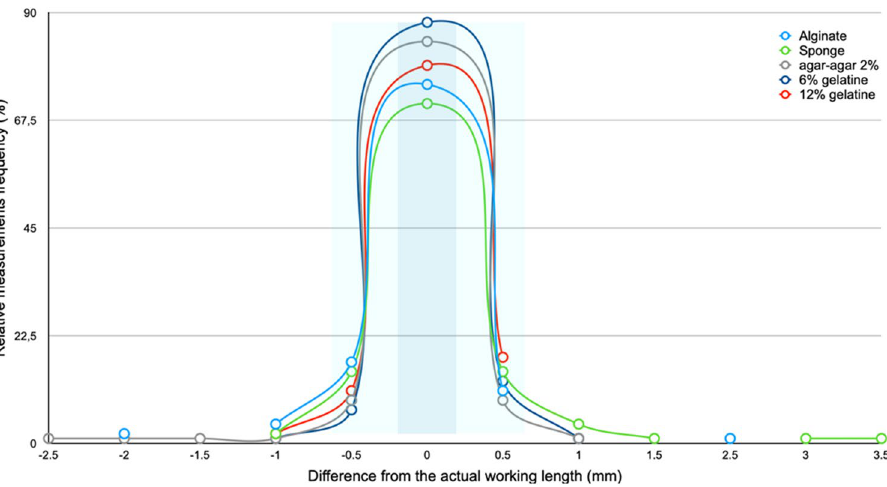
Figure 2. Diagram depicting the relative frequency (%) differences of the working length measurements obtained with the different embedding media and the actual working length of the root canals